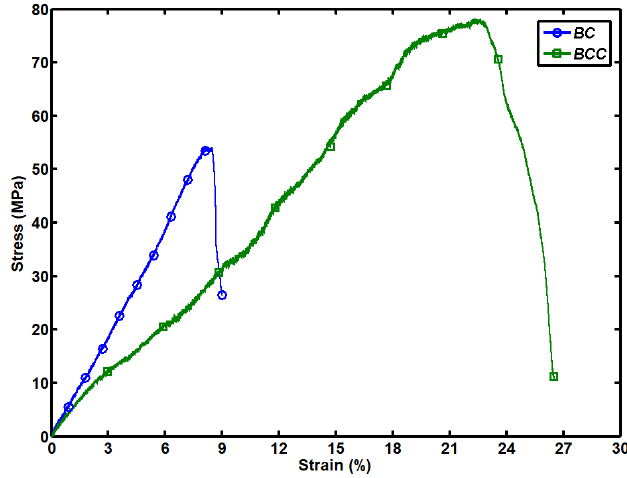
Figure 4. Stress–strain curve of pristine BC and BCC composite.